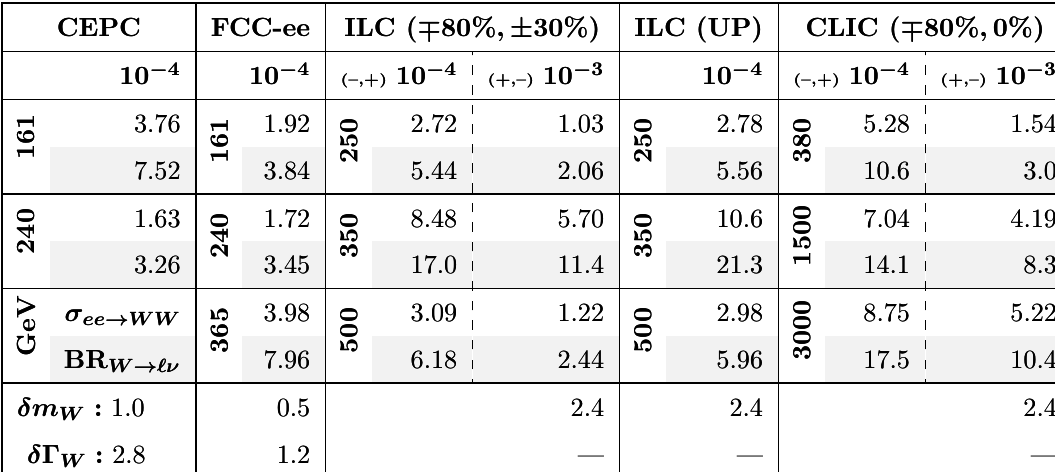
| | Table 6 . Mass, width and leptonic branching fractions of the W boson for all the future colliders at di(cid:11)erent energies. Deviations to m W and (cid:0) W are quoted in MeV. BR( W (cid:6) ! ‘ (cid:6) (cid:23) ) is marked in grey and (cid:27) ee ! WW is marked in white and both are normalized with their SM values. The values for the latter for FCC-ee 350 GeV run are numerically insigni(cid:12)cant and can be found in the